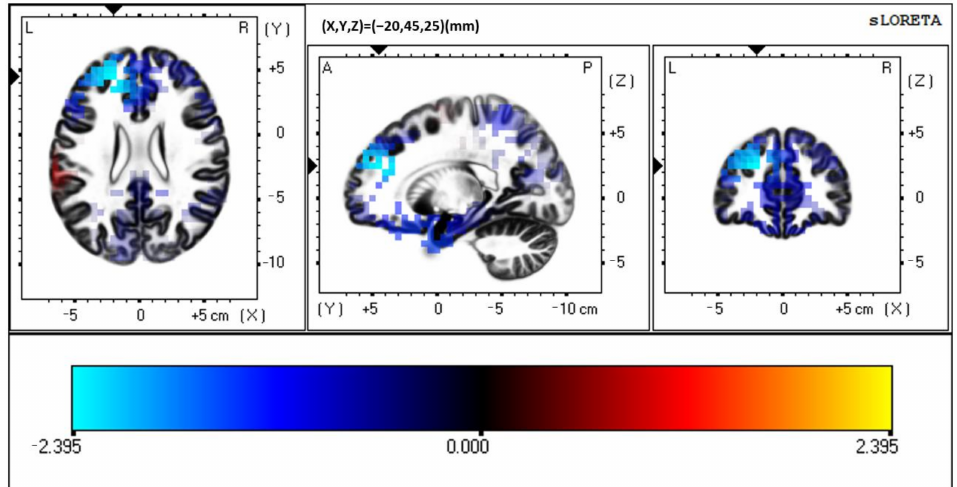
Figure 6. sLORETA auditory unisensory response, ADHD vs. Controls. Slice Viewer highlighting region of greatest neural activity difference between controls and those with ADHD. Views, from left to right, include a transverse, sagittal, and coronal cross-sectional area. ADHD > control activity at BA 10, left-hemispheric frontal